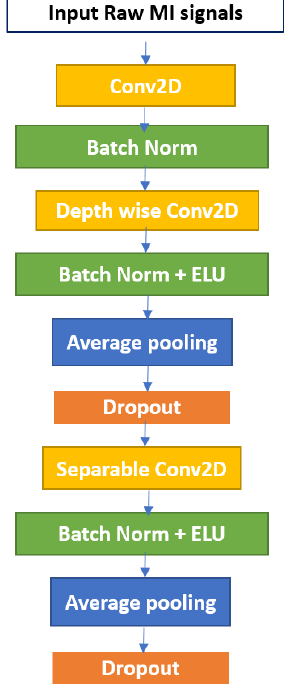
Figure 1. The EEGNet block.